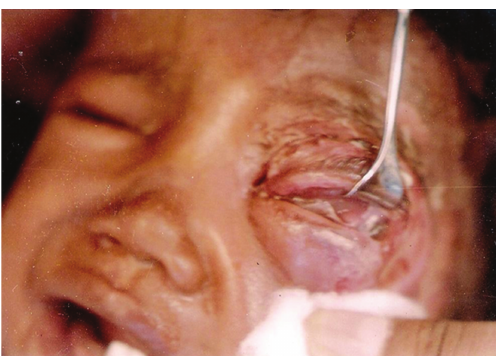
Figure 1: Pre treatment photograph of W. magnifica .